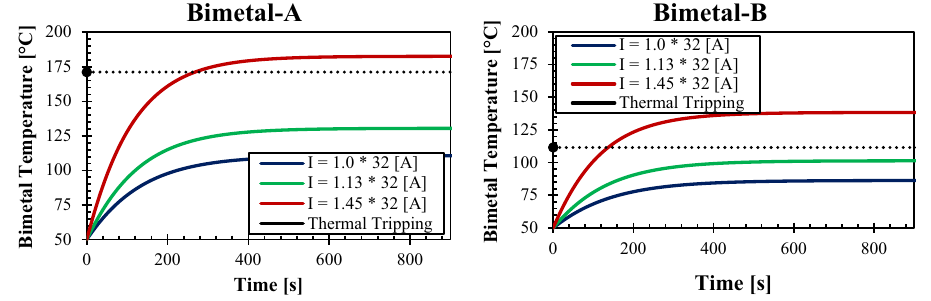
Figure 11. A comparison of BM-4 and BM-8 (Auerhammer Metallwerk GmbH) bimetals under the same conditions of electric currents, equal size and exact interfacing parameters with the switching mechanism of the branch circuit breaker 32 A.